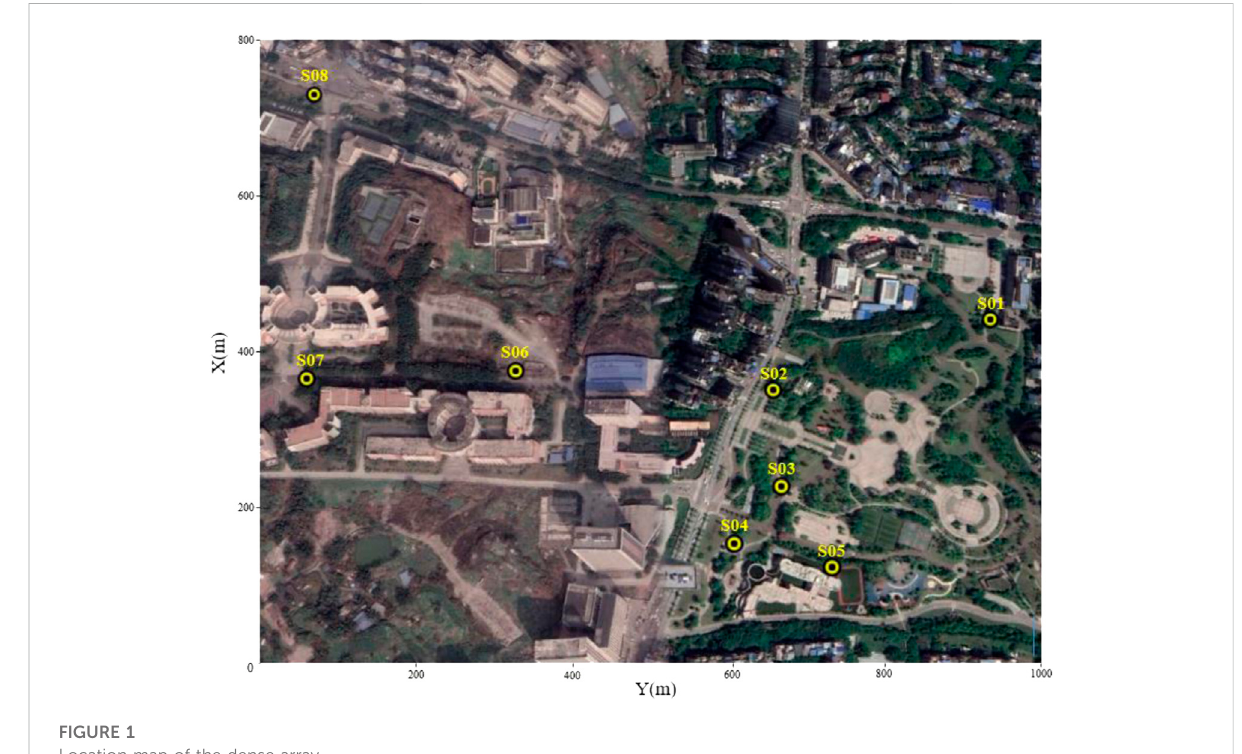
FIGURE 1 Location map of the dense array.